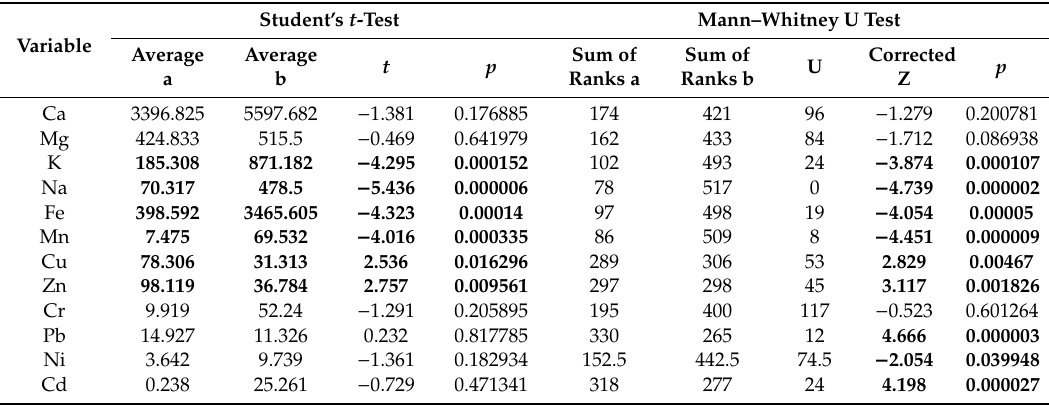
Table 3. Analysis of the di ff erences between the composition of new (a) and composted samples without exposure to UV light (b)—the highlighted results are significant with p <